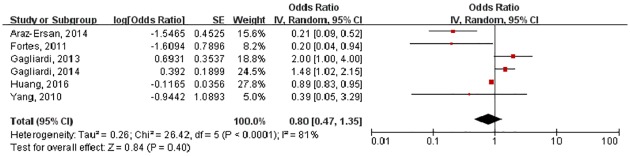
Forest plot showing the association between severe stage retinopathy of prematurity and hypertensive disorders in pregnancy.